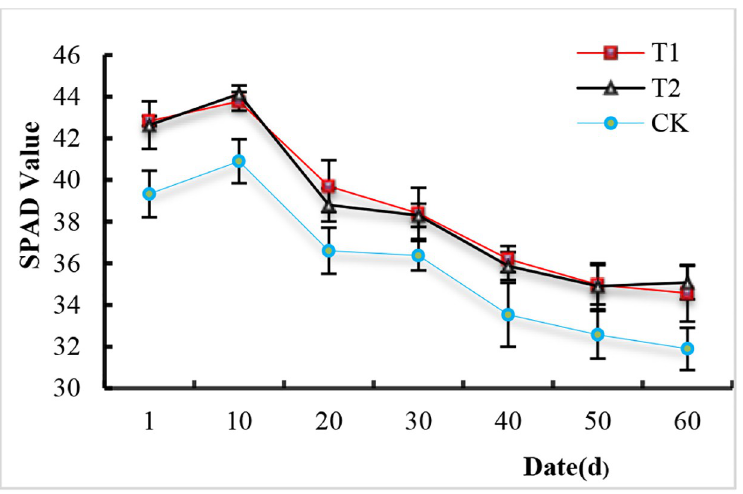
Fig 5. Effects of supplemental light on the chlorophyll content of tomato leaves. The values are the means (n = 3) ±